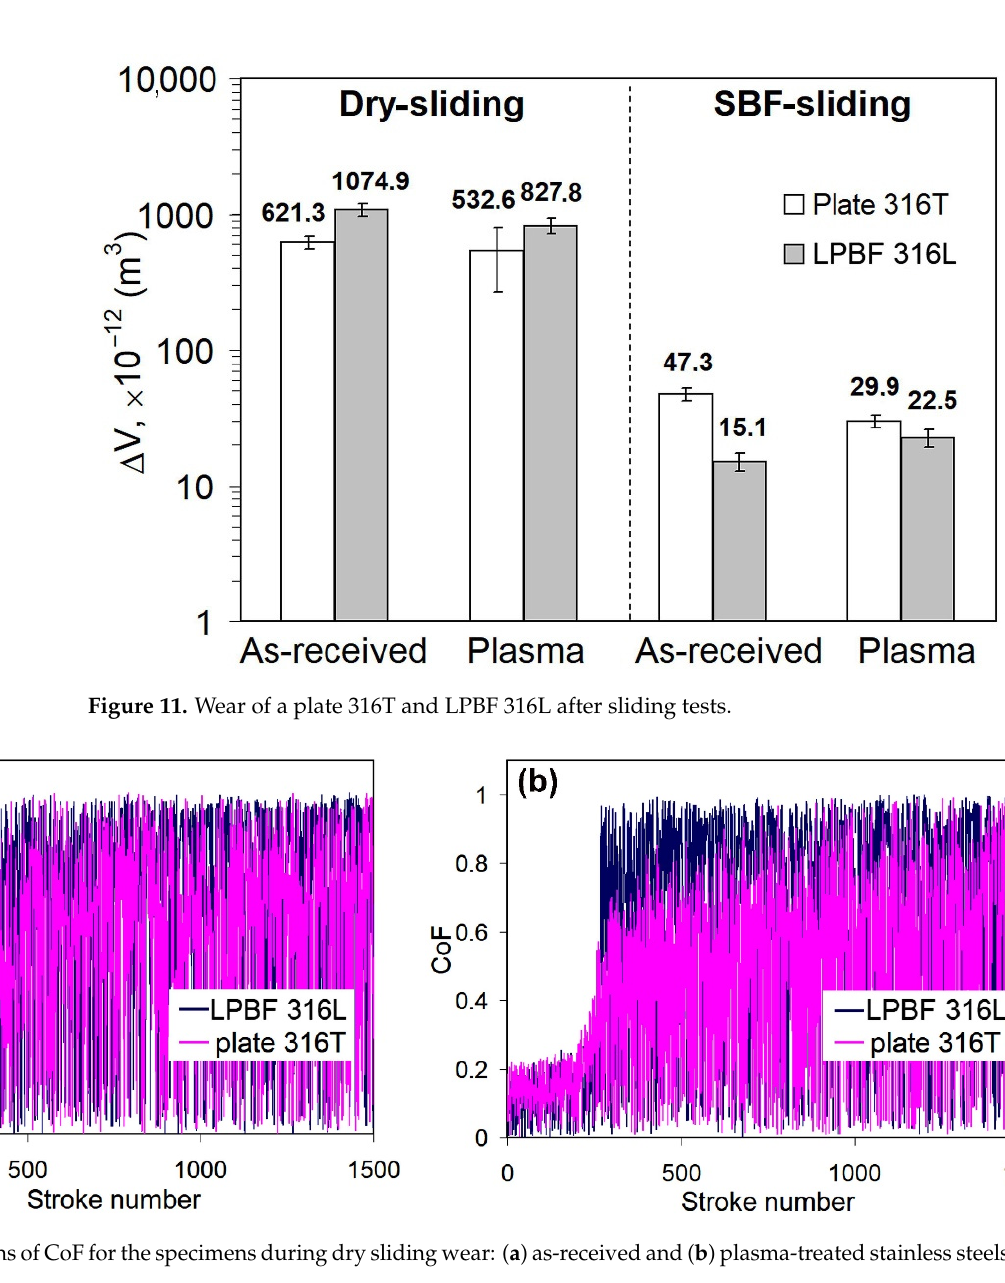
Figure 12. Variations of CoF for the specimens during dry sliding wear: ( a ) as-received and ( b ) plasma-treated stainless steels.